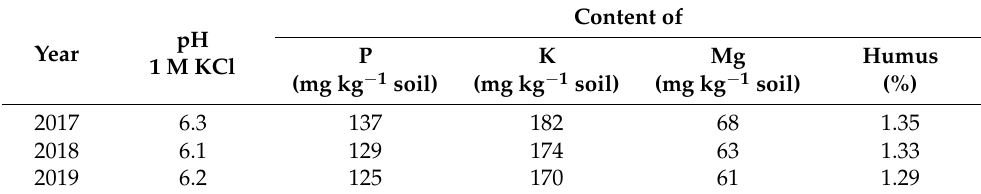
Table 1. Characteristics of some soil quality parameters before the experiment.